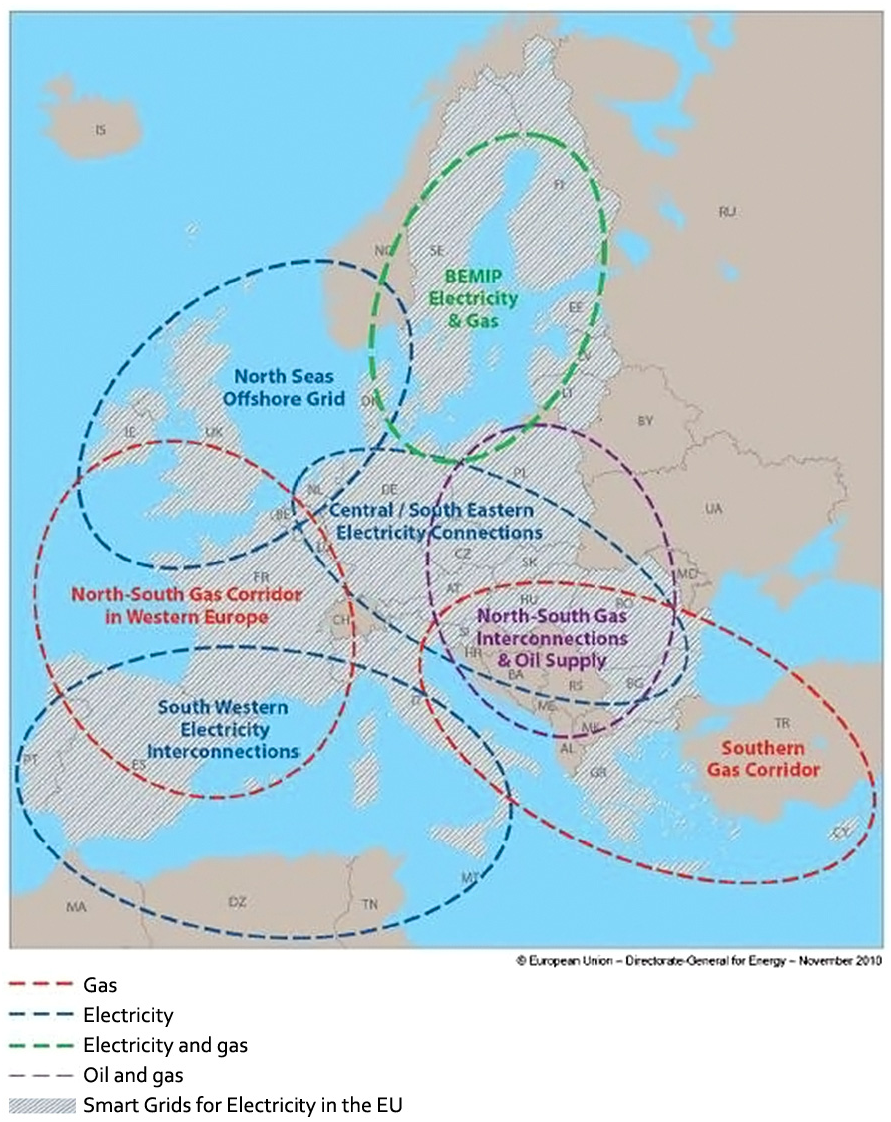
Figure 3. EU priority corridors for electricity, gas and oil